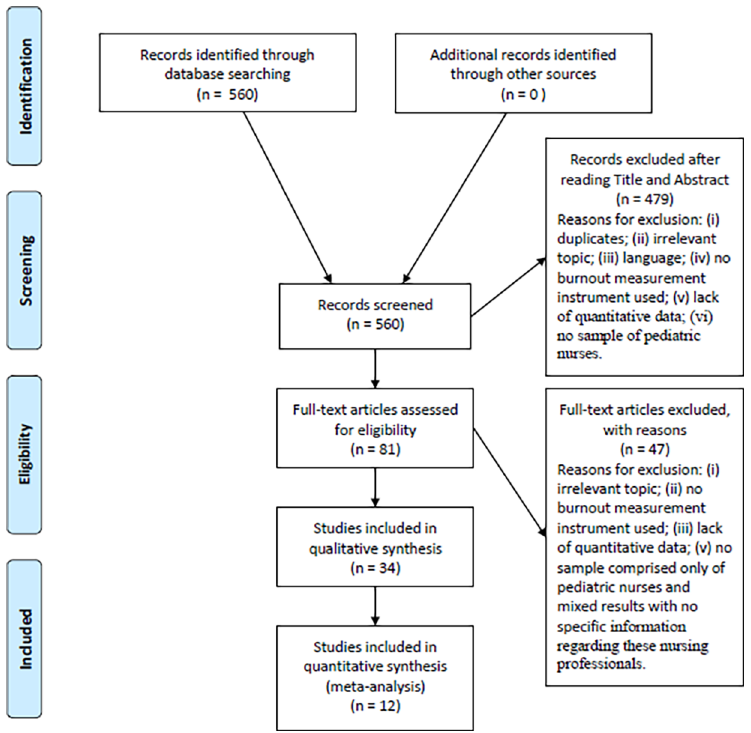
Fig 1. Flow diagram of the publication search